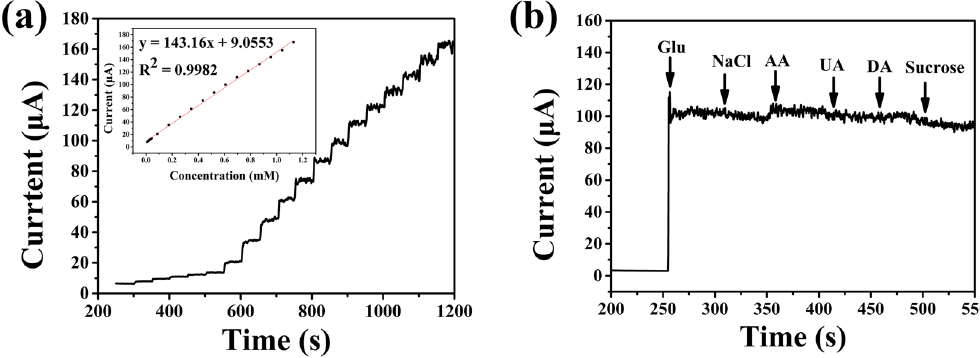
Figure 9. ( a ) Amperometric response of NiO hollow sphere/rGO/GCE at 0.58 V with the successive addition of glucose in 0.1 M NaOH. Inset shows the corresponding calibration curve. ( b ) Interference test of NiO hollow sphere/rGO/GCE toward the addition of glucose (Glu, 0.6 mM) and various interferents, including NaCl (0.06 mM), ascorbic acid (AA, 0.06 mM), uric acid (UA, 0.06 mM), dopamine (DA, 0.1 mM), sucrose (Suc, 0.06 mM), urea (0.06 mM), and cholesterol (Chol, 0.06 mM) in 0.1 M